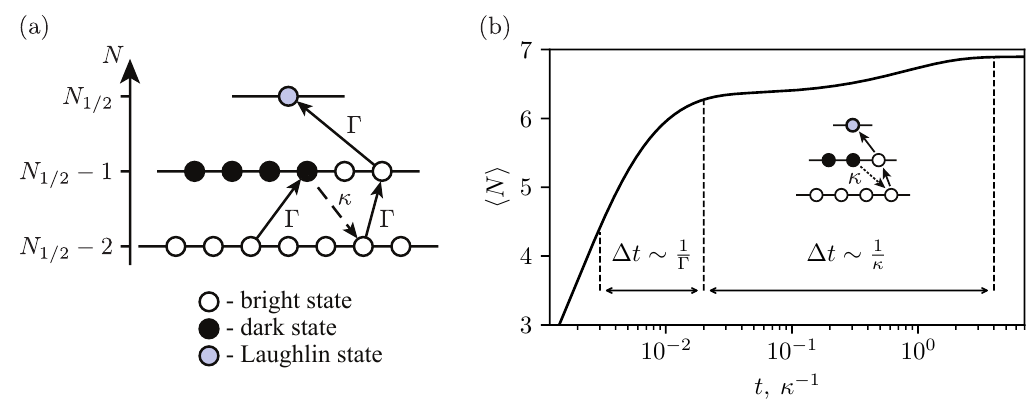
Figure 4: Preparation of the bosonic Laughlin state with a filling factor ν = 1 / 2. Even number N φ of flux quanta pierces the surface of the sphere rendering the Laughlin state non-degenerate. (a) Before reaching the Laughlin state at half filling, N = N , the system might get stuck in a dark state with two remote quasiholes (at 1 / 2 − 1). A loss and a subsequent refilling are needed for the system to escape N = N 1 / 2 the dark state and get a chance to be refilled to the Laughlin state. Such a sequence of processes corresponds to two quasiholes coming together due to the dissipative motion mechanism outlined in Fig. 2. (b) Deviation from the Laughlin state, ∆ N / N , = 7 initialized in the vacuum state. as a function of t for a small system with N 1 / 2 After quickly refilling to N ≈ 6 over time ∝ 1 / Γ (where κ/ Γ = 4 · 10 − 3 ) the system gets stuck in a configuration with two remote quasiholes for a time ∝ 1 /κ . Only after that time quasiholes recombine and the system approaches the Laughlin state. The plot is obtained by solving master equation (13) numerically (see Appendix C for